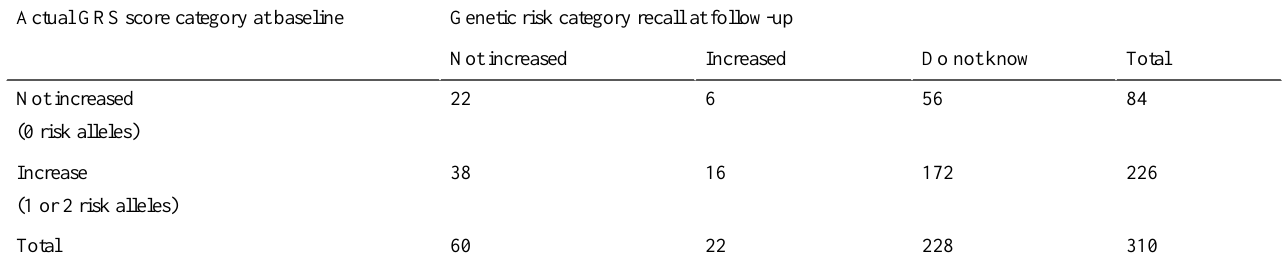
Table 5. Agreement between genetic risk score results and participants recall of risk score at follow-up.